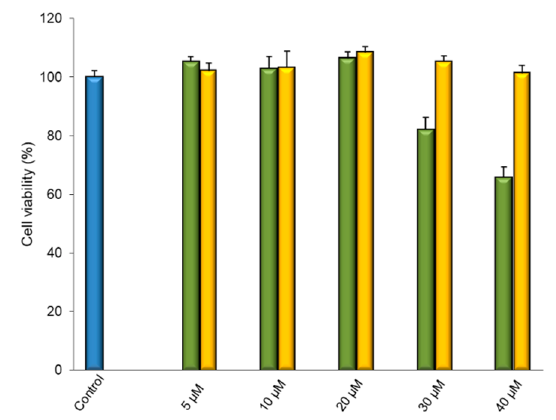
Figure 18. Effects on U373 cell viability of 24-h treatment with different concentrations of free (green bar) and complexed IDE (yellow bar). Cells were treated with free and complexed IDE at the indicated concentrations, and cell viability was measured using the MTT test. Results are presented as the means of three different experiments (six replicates for each point) ± standard deviation.